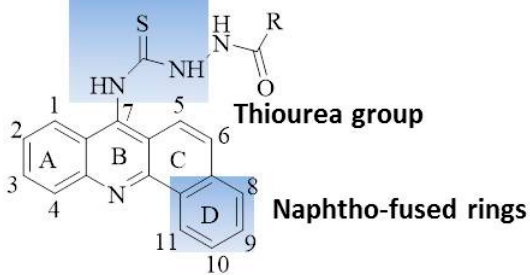
Figure 1. Hybrids of acridine and thiourea group giving acridine thiosemicarbazides.